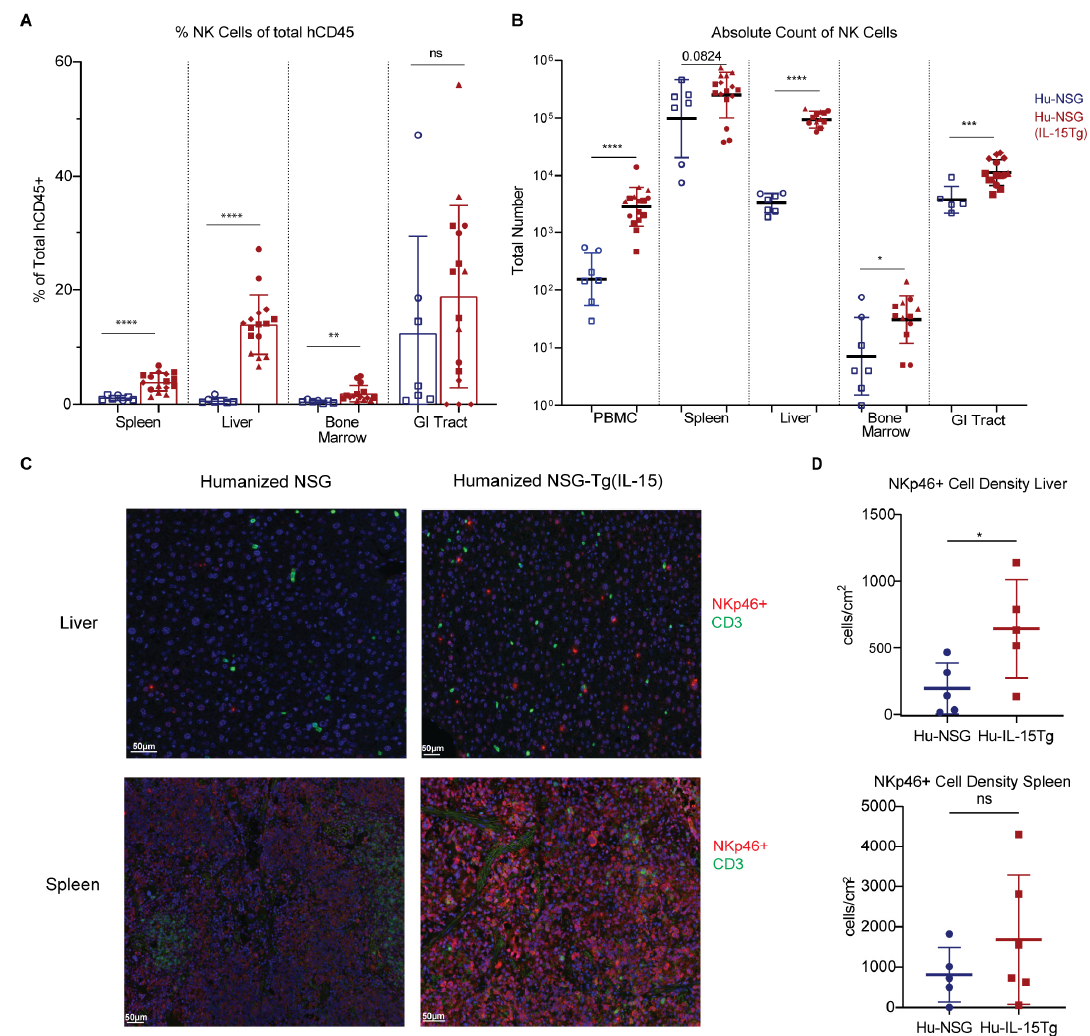
Figure 3. Hu-NSG-Tg(IL-15) mice support higher reconstitution of human natural killer cells than Hu-NSG mice across multiple organs. ( A ) Frequency of human NK cells in PBMC, spleen, liver, bone marrow, and gastrointestinal tract harvested from Hu-NSG ( n = 7, 2 unrelated donors) and Hu ‐ NSG ‐ Tg(IL ‐ 15) ( n = 16, 4 unrelated donors) mice 6 months post CD34 + HSC transplant. ( B ) Total number of human NK cells in PBMC, spleen, liver, bone marrow, and gastrointestinal tract harvested from Hu ‐ NSG ( n = 7, 2 unrelated donors) and Hu ‐ NSG ‐ Tg(IL ‐ 15) ( n = 16, 4 unrelated